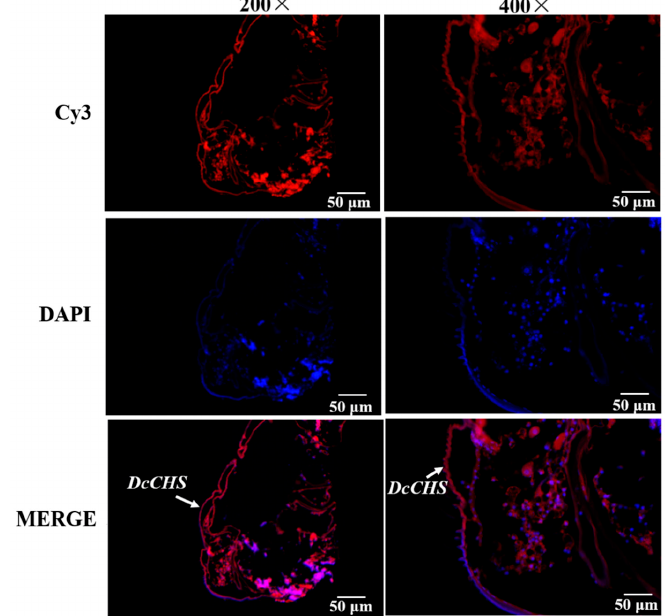
Figure 5. Fluorescence in situ hybridization (FISH) analysis of DcCHS in psyllid integument using DcCHS probe. The red color indicated the distribution of DcCHS transcript. The blue color indicated the distribution of cell nucleus in D. citri .